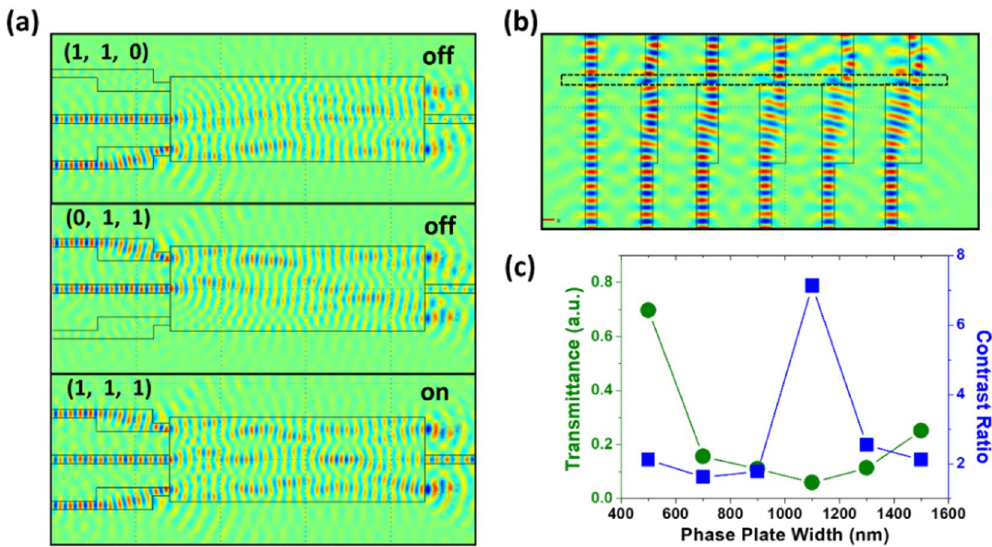
Figure 3. ( a ) Simulated electric field (E z ) of the XNOR gate with phase modulators in the waveguides of input A and input B. Boolean operations of “off” (top and middle panels) and “on” states (bottom panel) at different input conditions. “Off” and “on” states correspond to very low and high power transmission through the output port on the right. ( b ) Simulated electric field (E z ) distributions revealing the phase modulation at different widths of the phase tuning plate. ( c ) The transmittance and contrast ratio of the XNOR gate as a function of the width of the phase modulator. The contrast ratio is defined as the power of the “on” state over that of the “off”